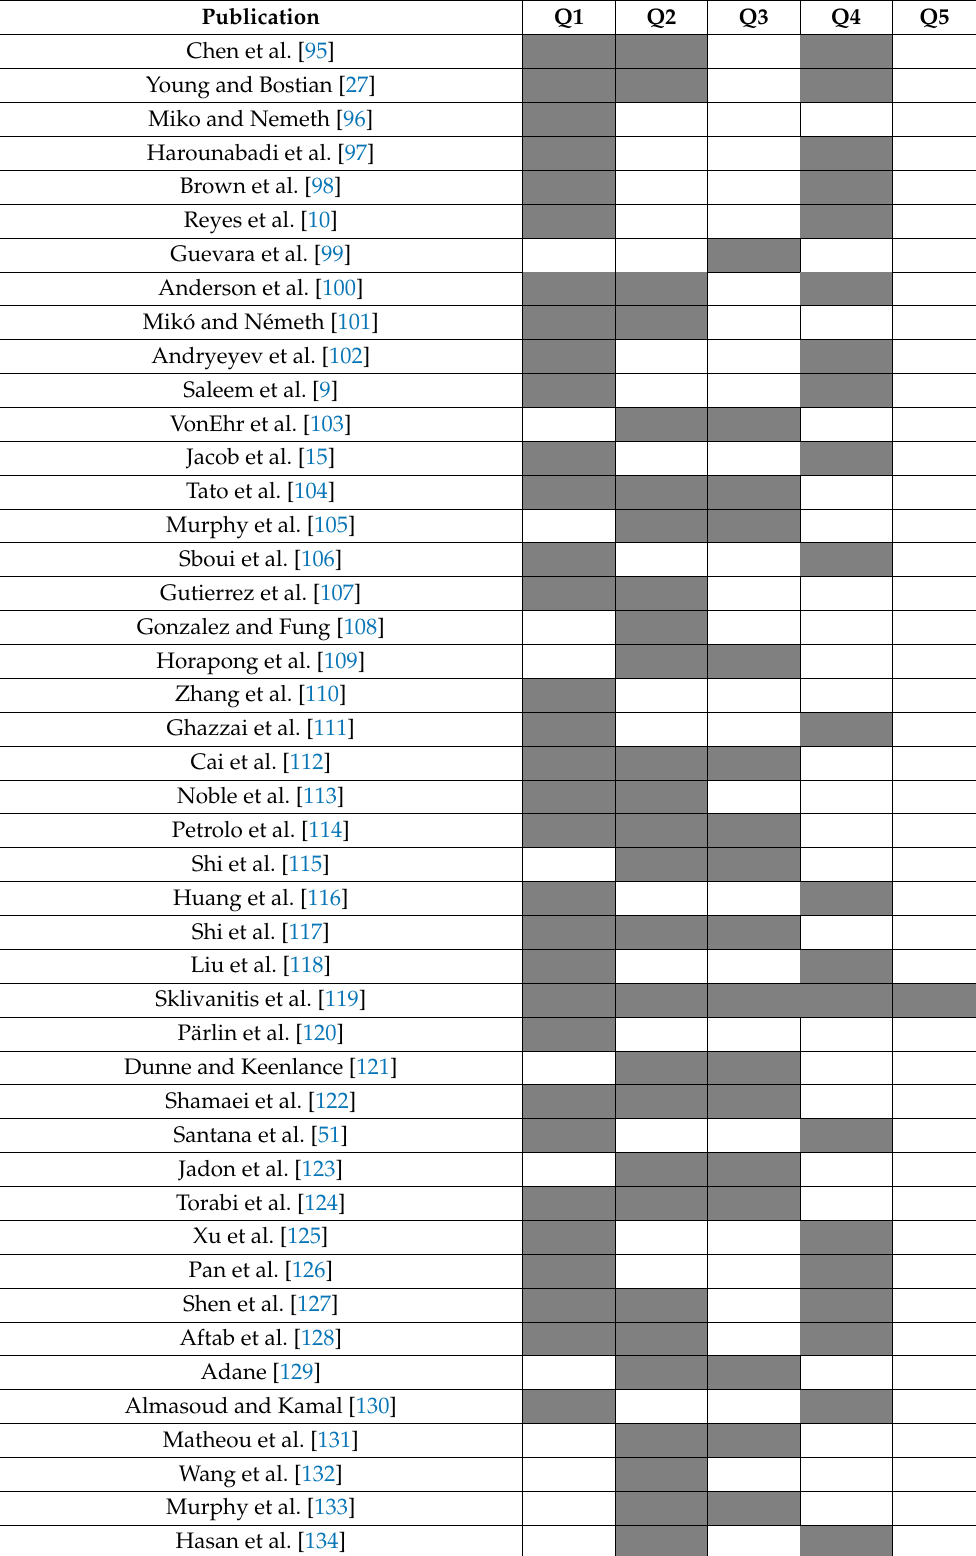
Table 2. Reviewed publications and their explored topics. On the columns Q1 to Q5, cells filled in gray color represent “yes” for the respective column, and “no”